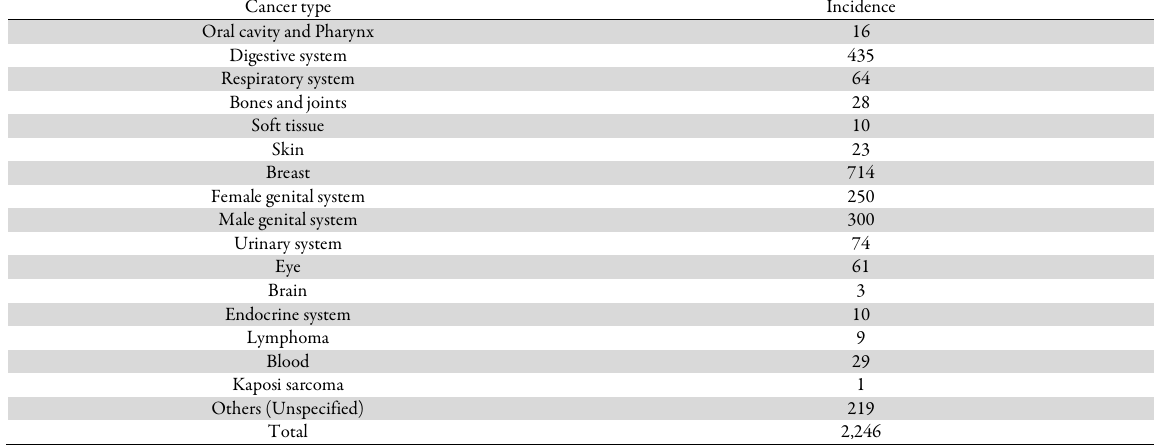
Table 2. Cancer incidence by categories of various cancer sites from UITH registry from 2007-2016 Cancer type